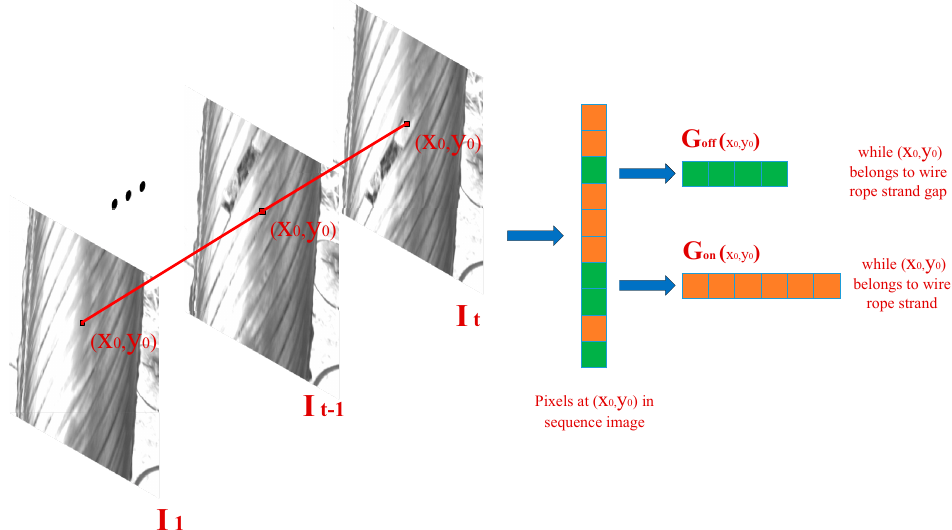
Figure 9. Composition of the temporal gray sample set.